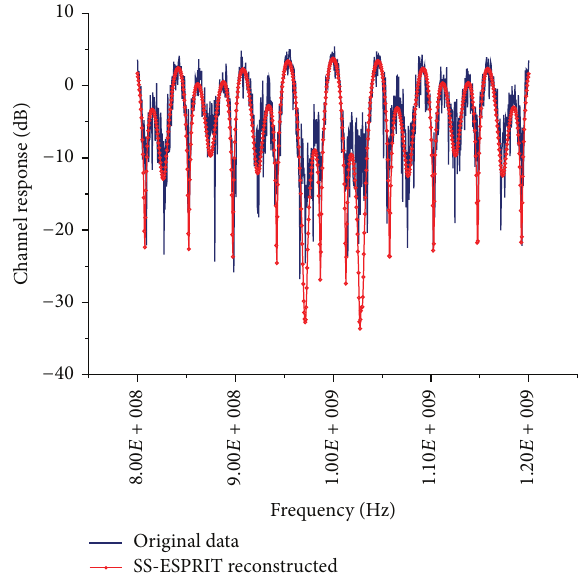
Figure 1: Comparison of the simulated channel response and the SS-ESPRIT reconstructed responses at 10dB SNR.